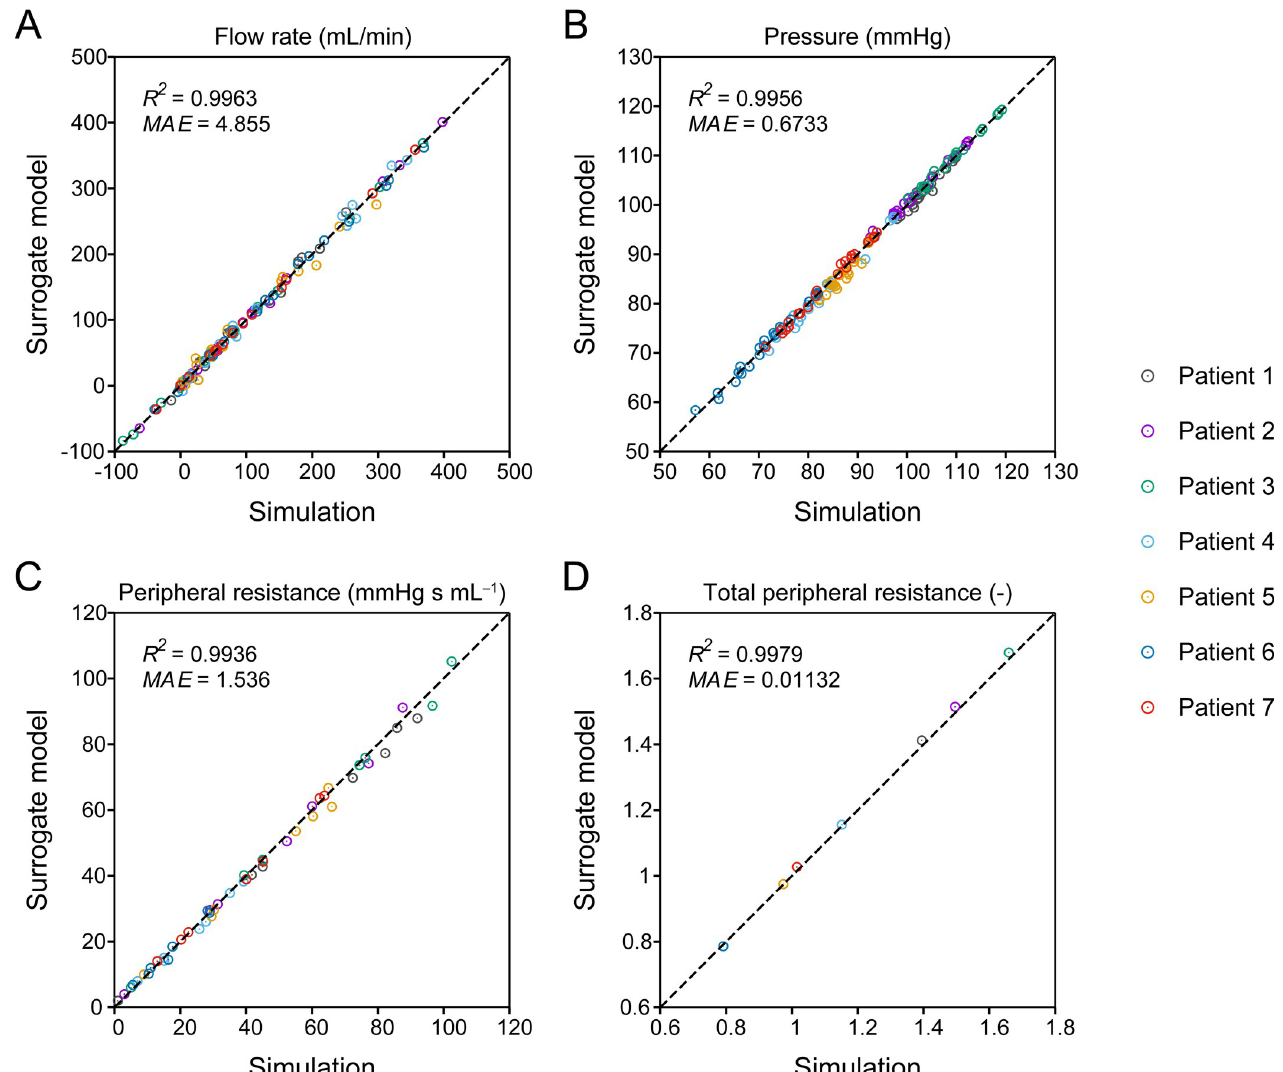
Fig 6. Comparison of one-dimensional–zero-dimensional (1D–0D) simulation and surrogate model predictions. The (A) flow rate, (B) pressure, (C) adjusted peripheral resistance of the circle of Willis, and (D) adjusted scaling factor for total peripheral resistance in seven patient-specific cases are compared. The negative flow rate indicates that the flow direction is opposite to the arrows in Fig 2. The R 2 scores and mean absolute errors (MAEs) of each quantity are depicted in the corresponding